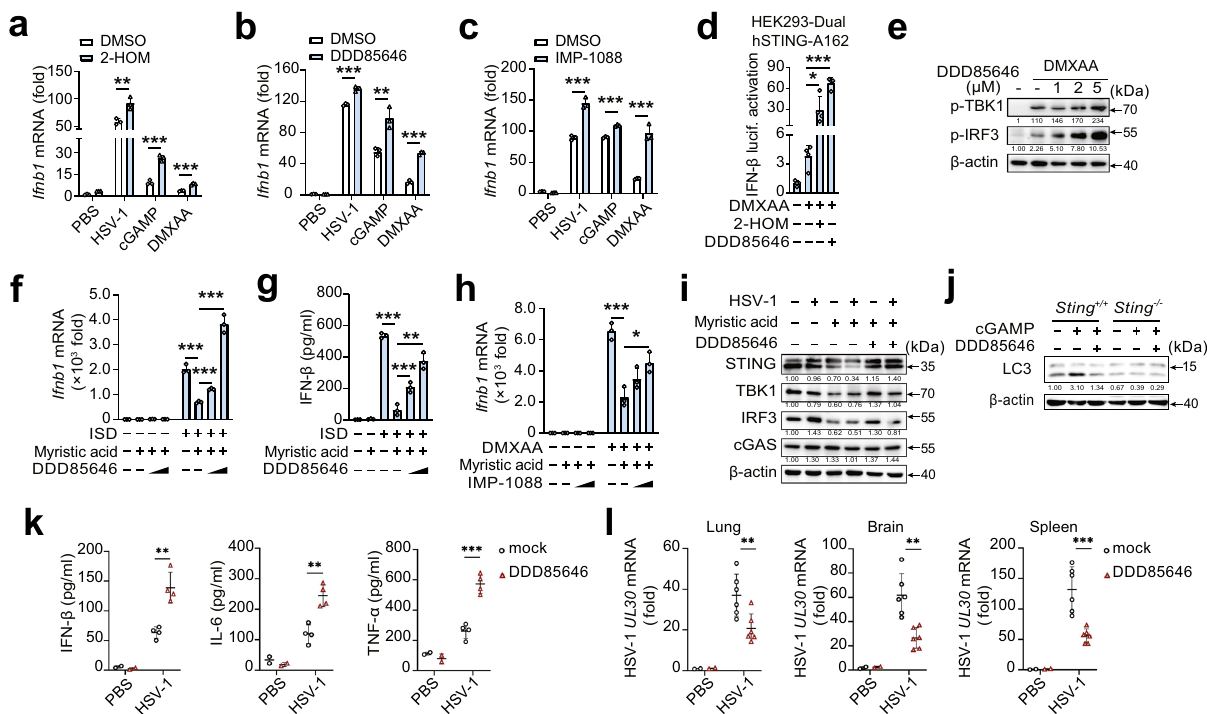
Fig. 5 | Myristic acid inhibits cGAS-STING activation via facilitating N-myristoylation. a – c Quantitative polymerase chain reaction (qPCR) analysis of Ifnb1 mRNA in peritoneal macrophages (PMs) pretreated with DMSO, 2-HOM, DDD85646, or IMP-1088, following HSV-1 infection, cGAMP or 5,6-dimethyl- xanthenone-4-acetic acid (DMXAA) stimulation, n =3 samples examined over 3 independent experiments. d Luciferase activity analysis of interferon (IFN)- β acti- vation in HEK293-Dual hSTING-A162 cells pretreated with DMSO, 2-HOM, or DDD85646, followed by DMXAA stimulation, n =3 samples examined over 3 inde- pendent experiments. e Immunoblot analysis of p-TBK1 and p-IRF3 in PMs pre- treated with DMSO or DDD85646, and then stimulated with DMXAA. f , g qPCR analysis Ifnb1 mRNAexpression( f )orenzyme-linkedimmunosorbentassay(ELISA) ( h ) analysis of IFN- β secretion inPMs pretreated with DDD85646, and then treated with myristic acid, followed by ISD stimulation, n =3 samples examined over 3 independent experiments. h qPCR analysis of Ifnb1 mRNA in PMs pretreated